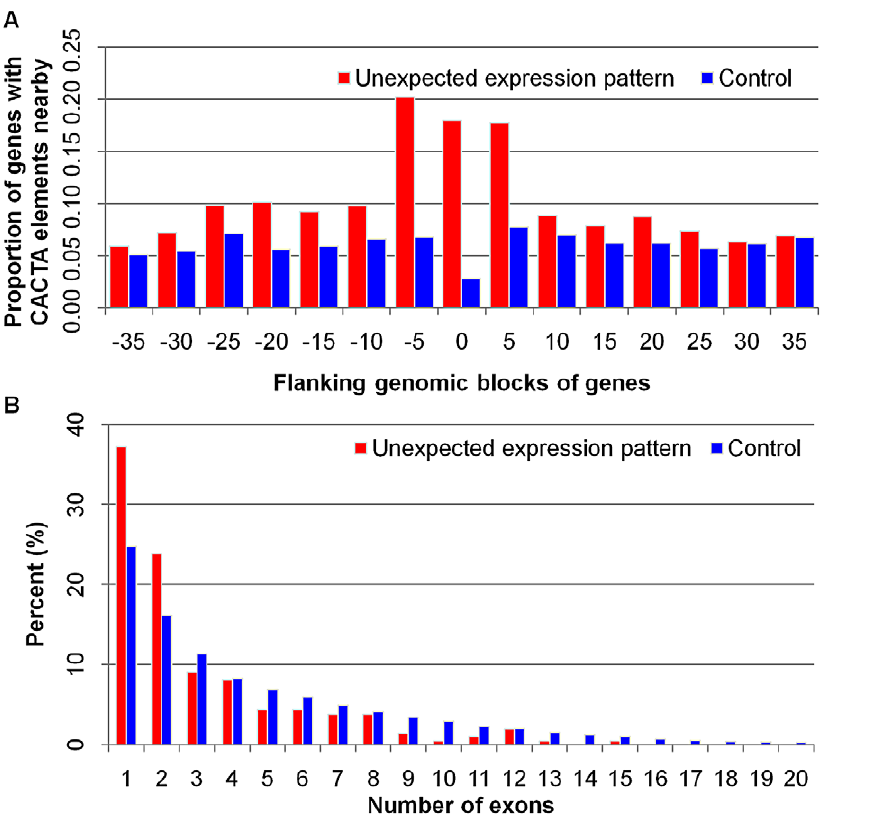
Figure 6. Enrichment of CACTA-like elements and fewer exon number bias in genes with unexpected expression patterns. (A) The proportion of genes with a CACTA-like element in different flanking genomic blocks. (B) Genes with unexpected expression patterns preferentially contain fewer exons.